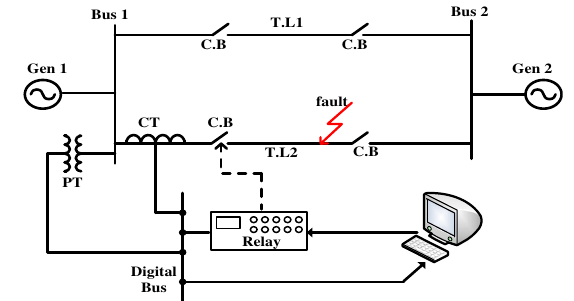
Fig. 4 A simplified digital protection